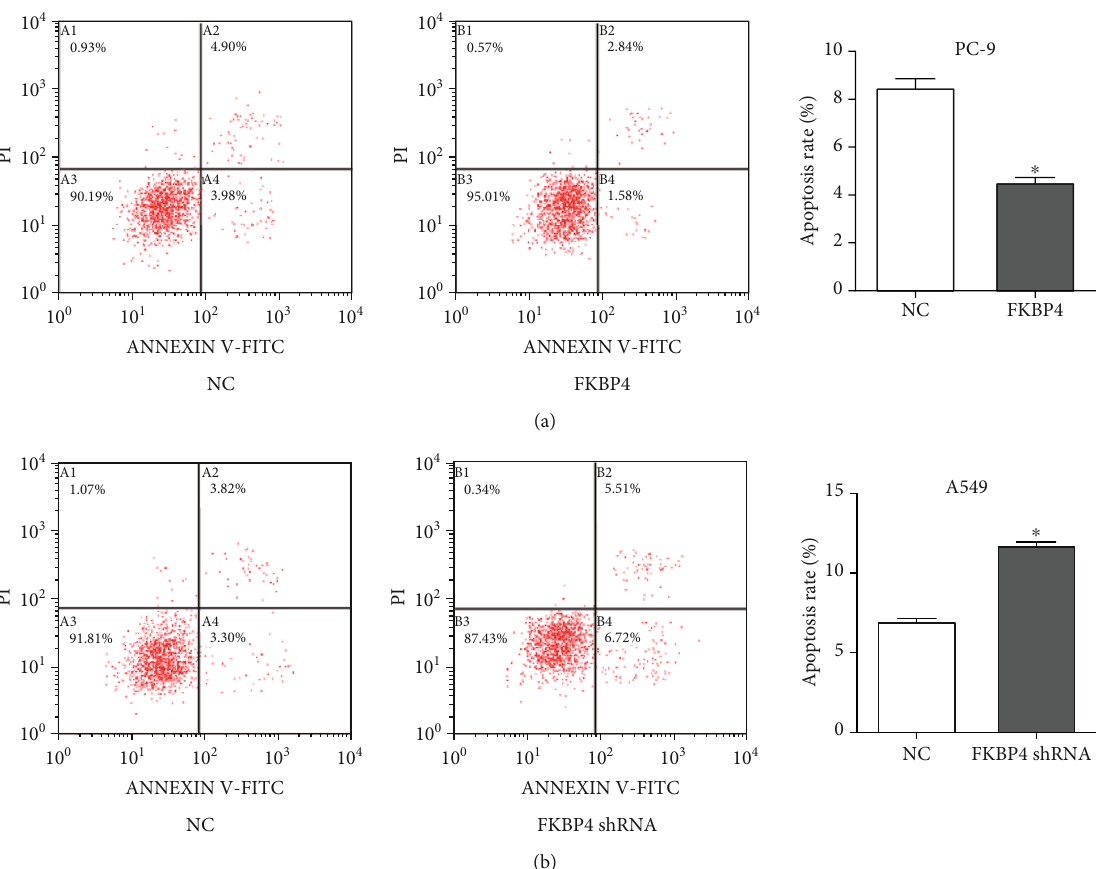
Figure 6: FKBP4 inhibits apoptosis of NSCLC cells: apoptosis of cells after overexpression of FKBP4 (a) in PC-9 cells and silencing of FKBP4 (b) in A549 cells; N = 3 , ∗ P < 0 : 05